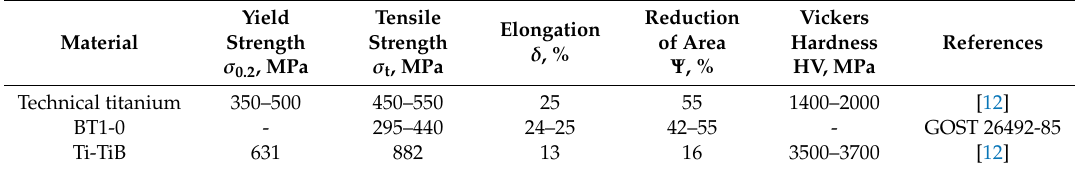
Table 1. Mechanical properties of titanium and Ti-TiB